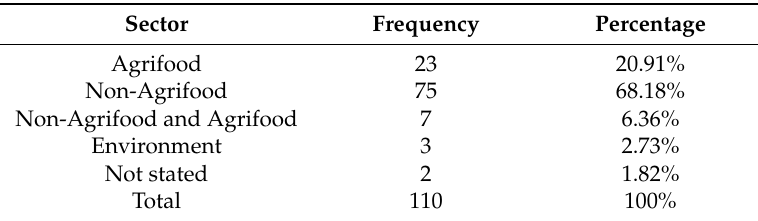
Table 2. The industry